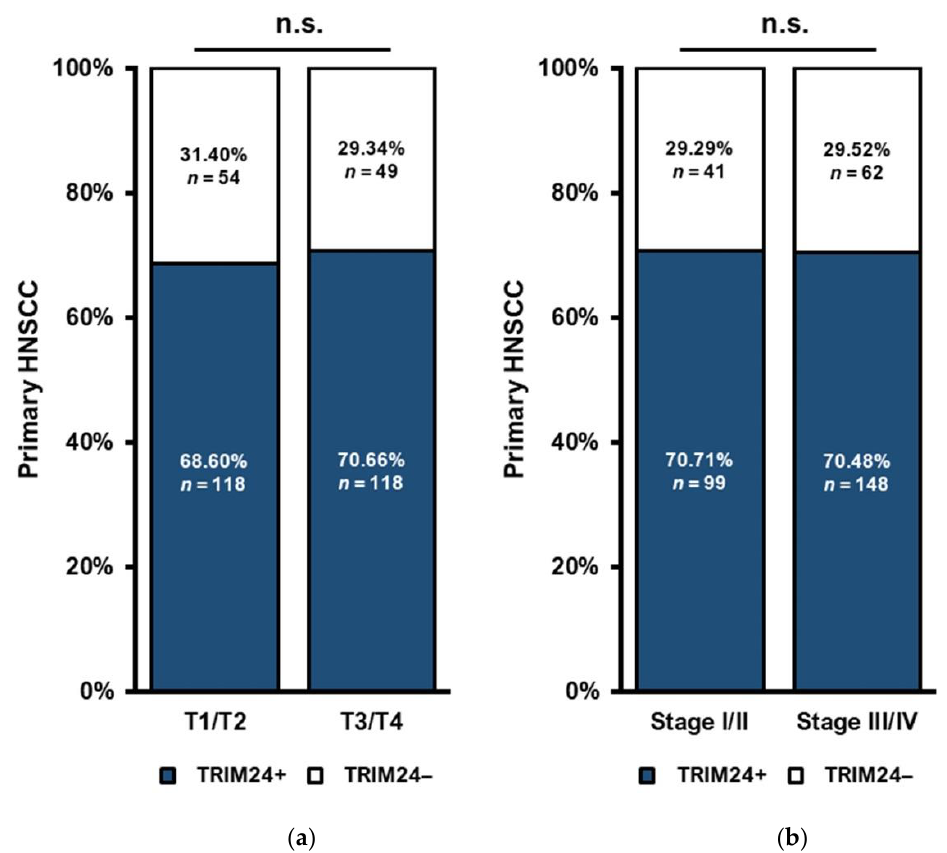
Figure 7. TRIM24 expression in PTs of different T − and UICC-stages. ( a ) There is no significant dif- ference in the proportion of TRIM24 expressing PTs between low T-Stages (T1/2) and higher T- Stages (T3/T4) ( p > 0.05). ( b ) There is no significant difference in the proportion of TRIM24 express- ing PTs between low UICC-Stages (I/II) and higher UICC-Stages (III/IV) ( p > 0.05). (n.s. = not signif- icant).